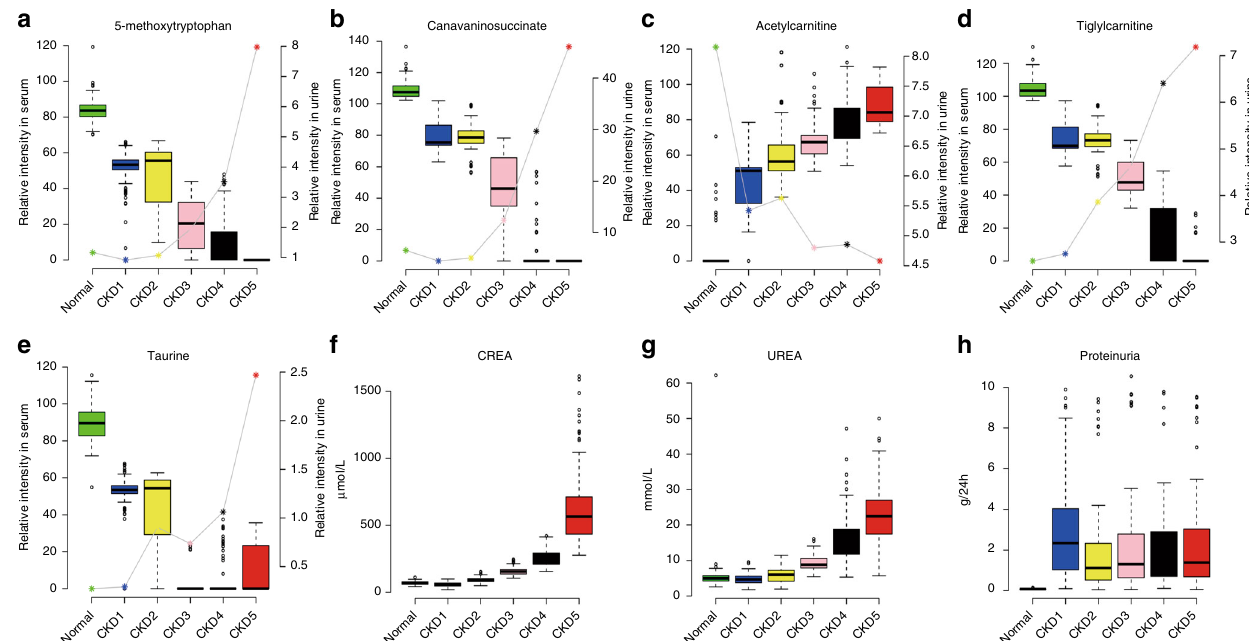
Fig. 1 The fi ve selected metabolites for the discrimination of the different CKD stages. a – e Boxplots showed the relative intensities of the fi ve metabolites in serum (left y-axis) and urine (right y-axis) including 5-MTP, CSA, acetylcarnitine, tiglylcarnitine and taurine across all fi ve CKD stages. f , g The levels of serum CREA and urea across all fi ve CKD stages. h The levels of proteinuria across all fi ve CKD stages. Dot plot and line showed the relative intensities of the fi ve urinary metabolites including 5-MTP, CSA, acetylcarnitine, tiglylcarnitine and taurine across all fi ve CKD stages. In the boxplot, the median is represented by the center line, 75 percentile is represented by the upper bound of the box, 25 percentile is represented by the lower bound of the box, minimum is represented by the lower whisker, and maximum is represented by the upper with CKD and healthy controls (Fig. 1h). Four metabolites had negative associations (5-MTP p = 8.22 × 10 − 13 , CSA p = 2.99 × 10 − 5 , tiglylcarnitine p = 7.17 × 10 − 9 and taurine p = 1.63 × 10 − 7 ), and acetylcarnitine had a positive association ( p = 3.19 × 10 − 13 ).